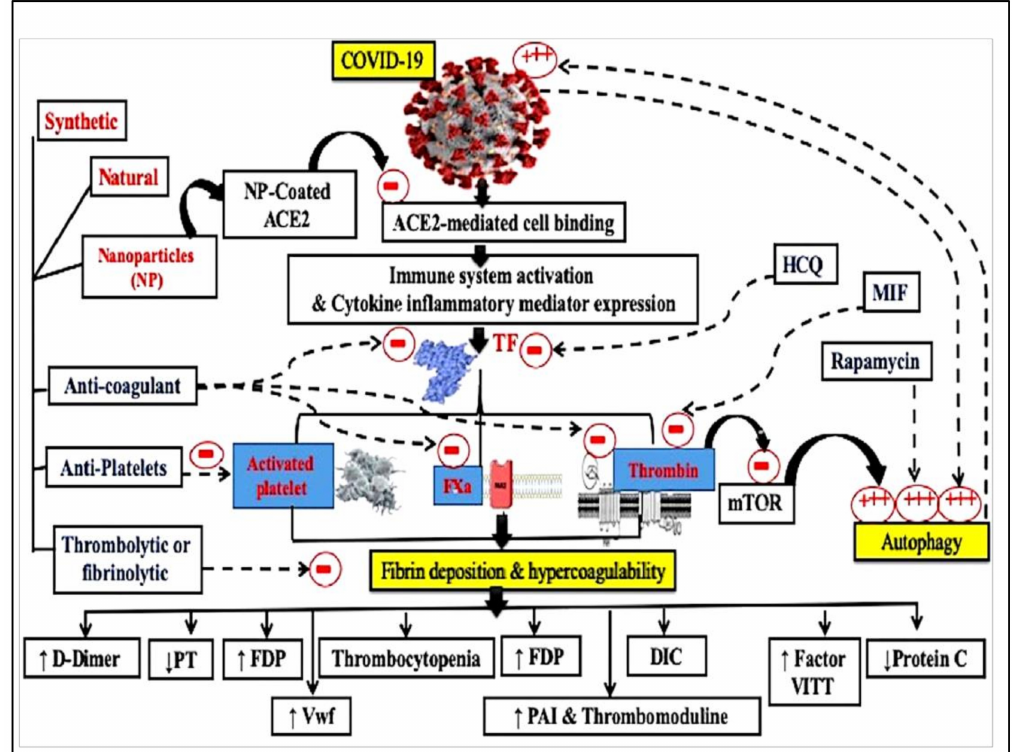
Figure 1. Schematic diagram representing the different coagulation system mechanisms and possible types of coating nanoparticles for targeting ang I and II receptors. DIC, disseminated intravascular co- agulation; Fxa, activated factor x; PT, prothrombin time; TF, tissue factor; Hydroxychloroquine—HCQ; Macrophage migration inhibitory factor—MIF; Fibrin degradation products—FDP; Von Willebrand factor—Vwf; Mammalian target of rapamycin—mTOR; plasminogen activator